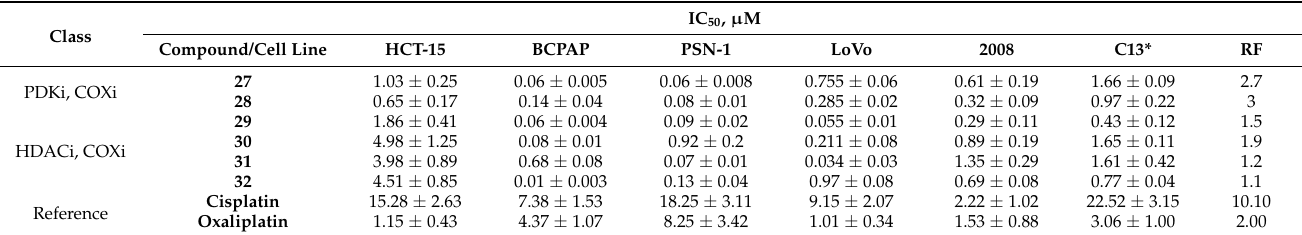
Table 15. Antiproliferative activity of cisplatin and platinum(IV) prodrugs 27–32 on HCT-15 (human colon carcinoma), BCAP (thyroid cancer), PSN-1 (pancreatic cancer), LoVo (colon cancer), 2008 (ovarian adenocarcinoma), and C13* (cisplatin- resistant ovarian adenocarcinoma) cell lines. Resistance factor (RF) = IC 50 (C13*)/IC 50 (2008). IC 50 , µ Class